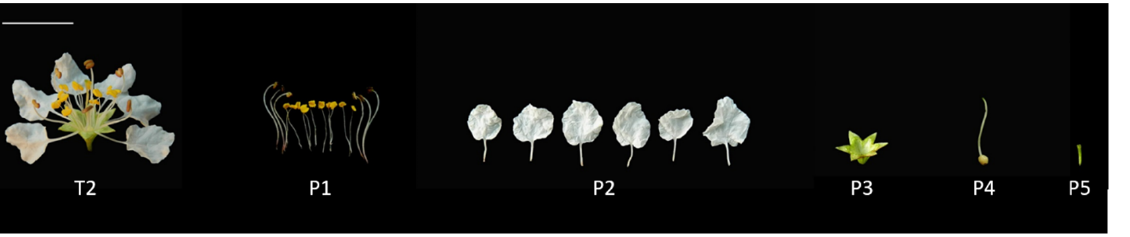
Figure 10. Single flower and its five floral organs in L. caudata . T2, single flower; P1, stamen; P2, petal; P3, calyx; P4, pistil; P5, pedicel; bar, 1 cm.